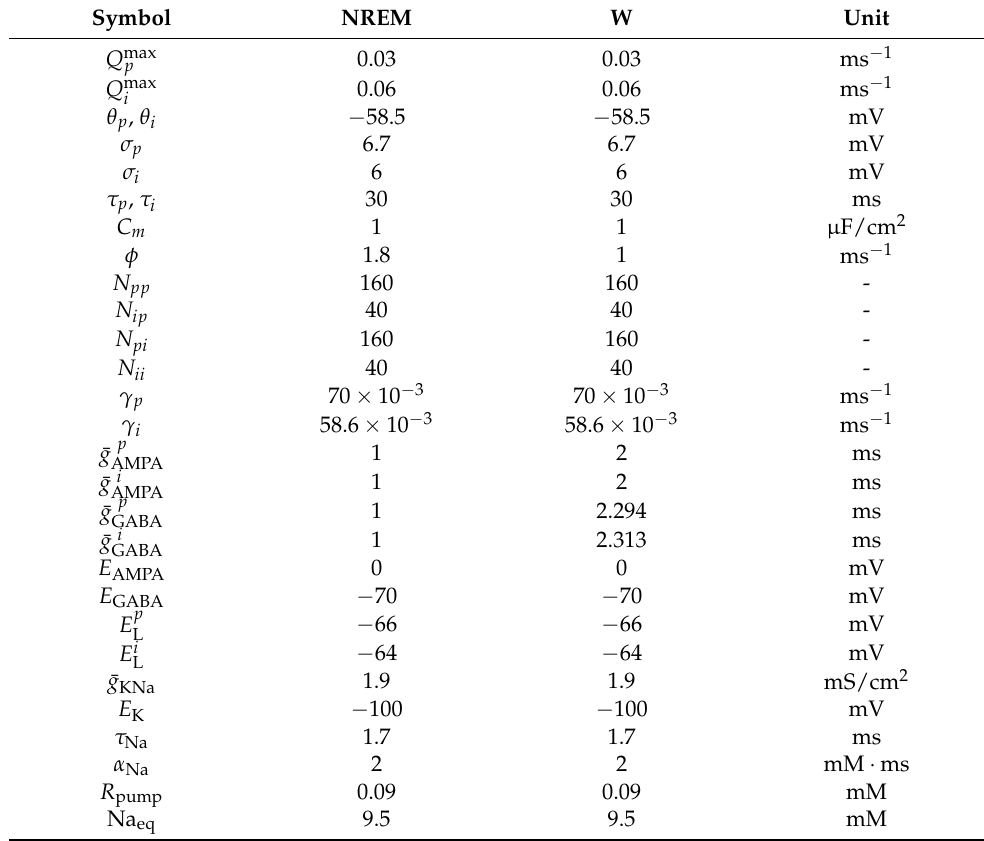
Table 2. Parameter values for the one-cortical-column